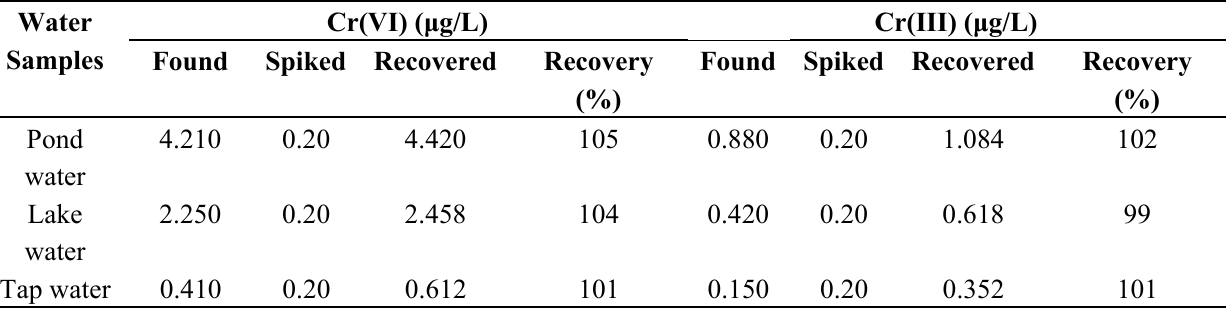
Table 8. Speciation of Cr(VI) and Cr(III) in environmental water samples ( n =